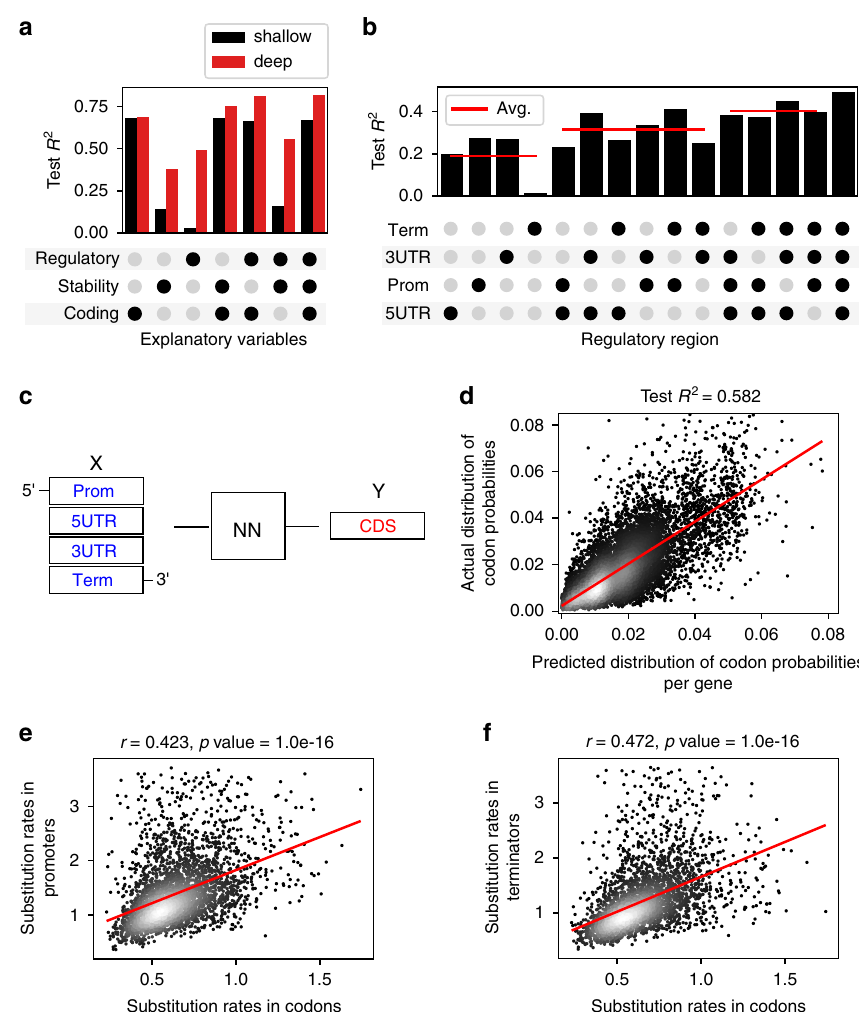
Fig. 2 Coding and cis-regulatory regions jointly contribute to gene expression prediction. a Test R 2 with different combinations of coding (codon prob.), mRNA stability (see Supplementary Fig. 1c) and cis -regulatory regions, using shallow (black) and deep modeling (red). b Test R 2 with deep models trained on different combinations of cis -regulatory regions. Red lines denote mean values. c Schematic depiction of deep neural network (NN) for prediction of codon probabilities (Y) based on regulatory DNA as input (X). d Actual versus predicted distribution of codon probabilities as predicted from non-coding DNA regions based on the model for prediction of codon probabilities based on regulatory DNA as input ( n = 11,947). Red line denotes least squares fi t. e Evolutionary substitution rates in promoter vs. coding regions in orthologous genes of 14 yeast species ( n = 3248). Red line denotes least squares fi t. f Evolutionary substitution rates in terminator vs. coding regions in orthologous genes of 14 yeast species ( n = 3248). Red line denotes least squares fi t. Source data are provided as a Source data fi